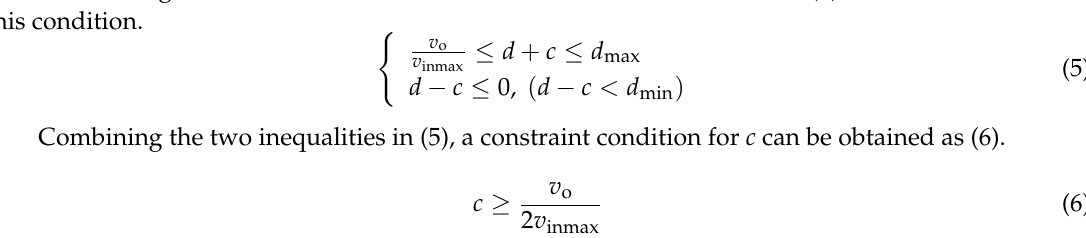
Figure 3. Switching modes of double-switch buck-boost converter. ( a ) Buck mode, S 1 ON and S 2 OFF in ( d + c ) T s , ( b ) buck mode, S 1 OFF and S 2 OFF in (1 − d − c ) T s , ( c ) boost mode, S 1 ON and S 2 ON in ( d − c ) T s , and ( d ) boost mode, S 1 ON and S 2 OFF in (1 − d + c ) T s .